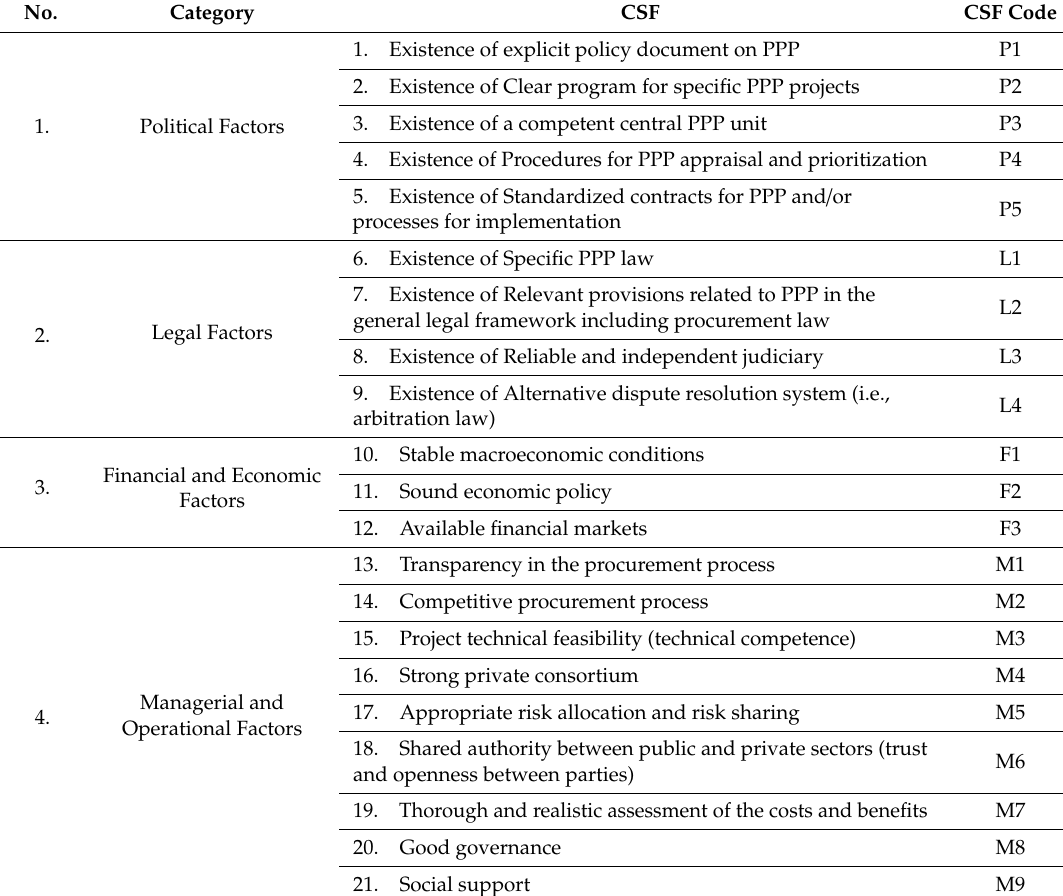
Table 2. Critical success